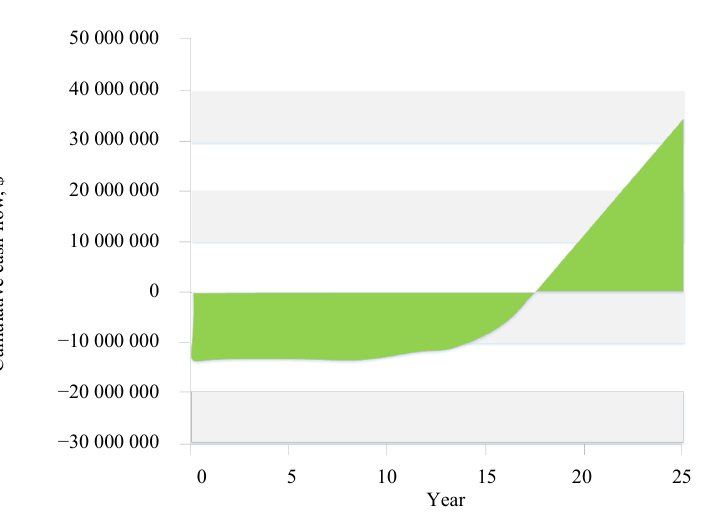
Fig. 5 Cumulative cash flow – Double axis